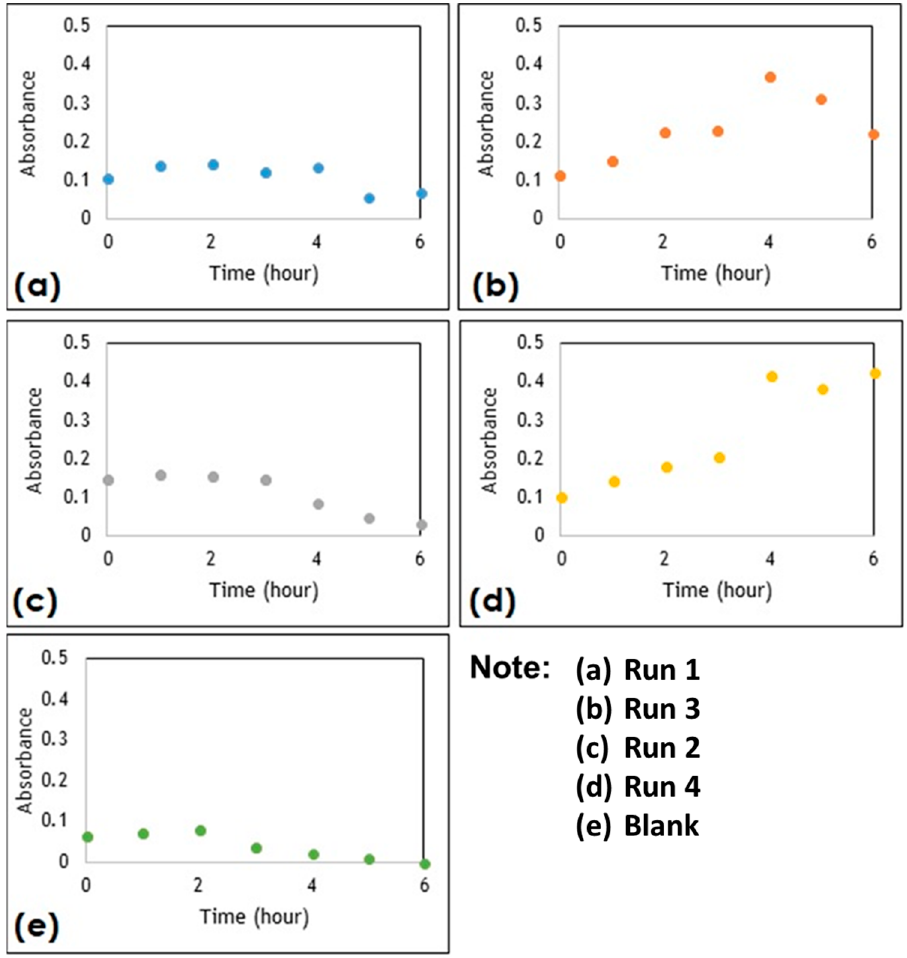
Figure 5. Turbidity changes for each variation and the blank in calcium alginate